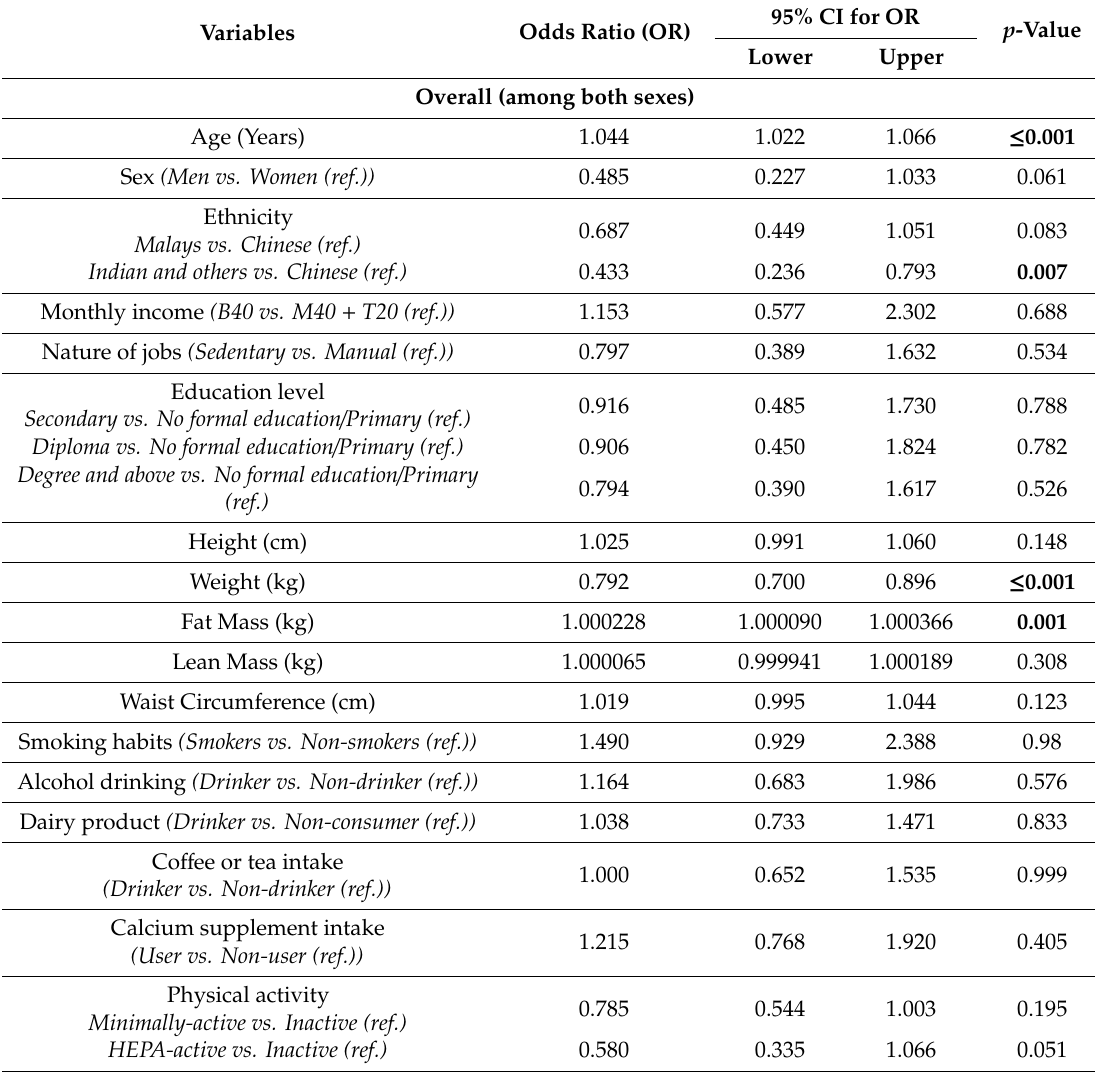
Table 1. Predictors of suboptimal bone health of the study